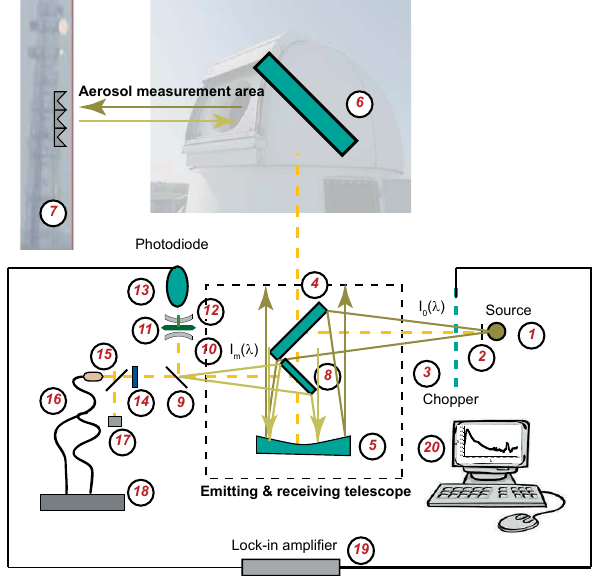
Fig. 1. Setup of SÆMS. (1) High-pressure Xe-arc lamp, (2) en- trance pinhole (3) chopper, (4, 8) flat mirror, (5) parabolic mirror, (6) adjustment mirror, (7) retroreflector arrays, (9, 15) beam split- ter, (10, 12) lens, (11) filter at 550nm (13) photodiode, (14) filter, (16) bifocal optical fiber, (17) CCD camera, (18) spectrometer, (19) lock-in amplifier, and (20) computer. The light (intensity I 0 ) from source 1 is transmitted into the atmosphere via mirrors 4, 5, and 6. The light reflected by the retroreflector 7 (intensity I m in the case of the measurement tower and I r in the case of the reference tower) is then directed via the mirrors 6, 5, and 8 to the 550nm photodiode (13) and the spectrometer 18.